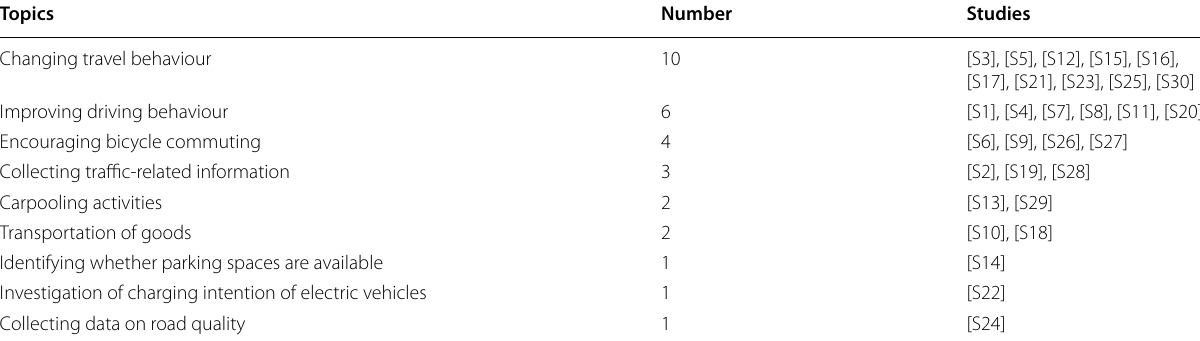
Table 8 Topics supported by